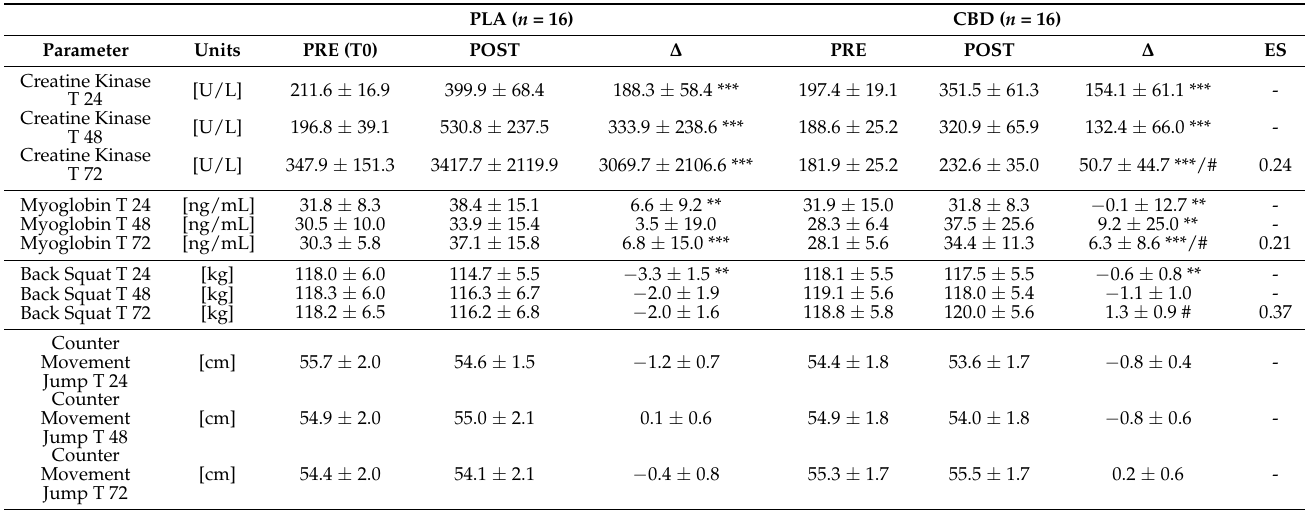
Figures represent means ± SEM. PRE: pre training, POST: post training. ∆ : corresponding differences. Asterisks indicate significant differences in time (*: p < 0.05, **: p < 0.01, ***: p < 0 .001). Hash indicates significant difference between groups (#: p < 0.05). Effect sizes Nutrients 2021 , 13 , x FOR PEER REVIEW ( ES = 2 · t / DF ) are indicated in case of significant group effects.